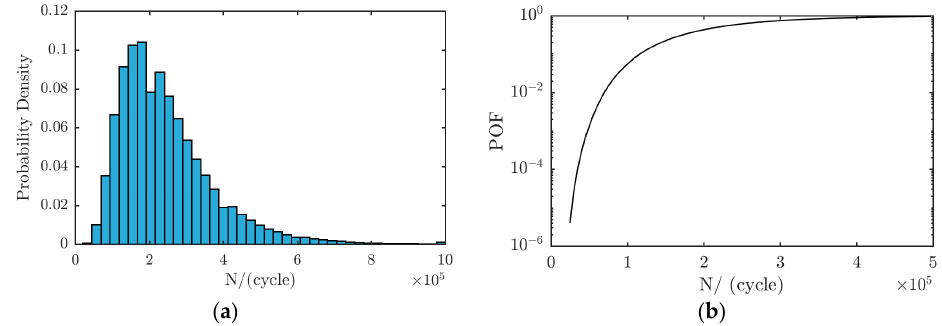
Figure 11. YZ3 test specimen: ( a ) fatigue life distribution and ( b ) failure probability.